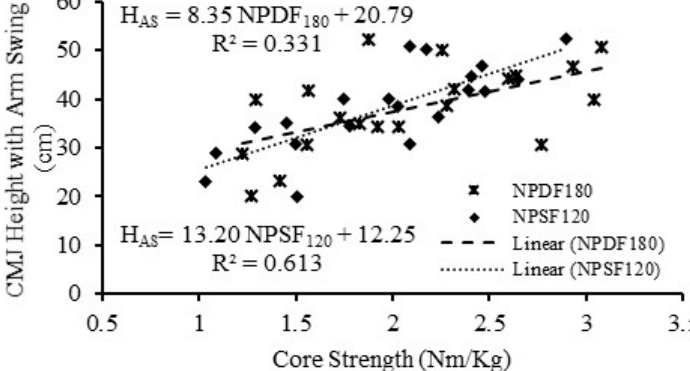
Figure 4. Results of linear regression analyses of CMJ height with arm-swing (H AS ) with 12 core strength measurements (n = 20), which were tested on a dynamometer and included normalized (with body mass) peak torque during dynamic extension/flexion at 60, 120, and 180° per second and normalized peak torque during static extension/flexion at 60, 90, and 120°.